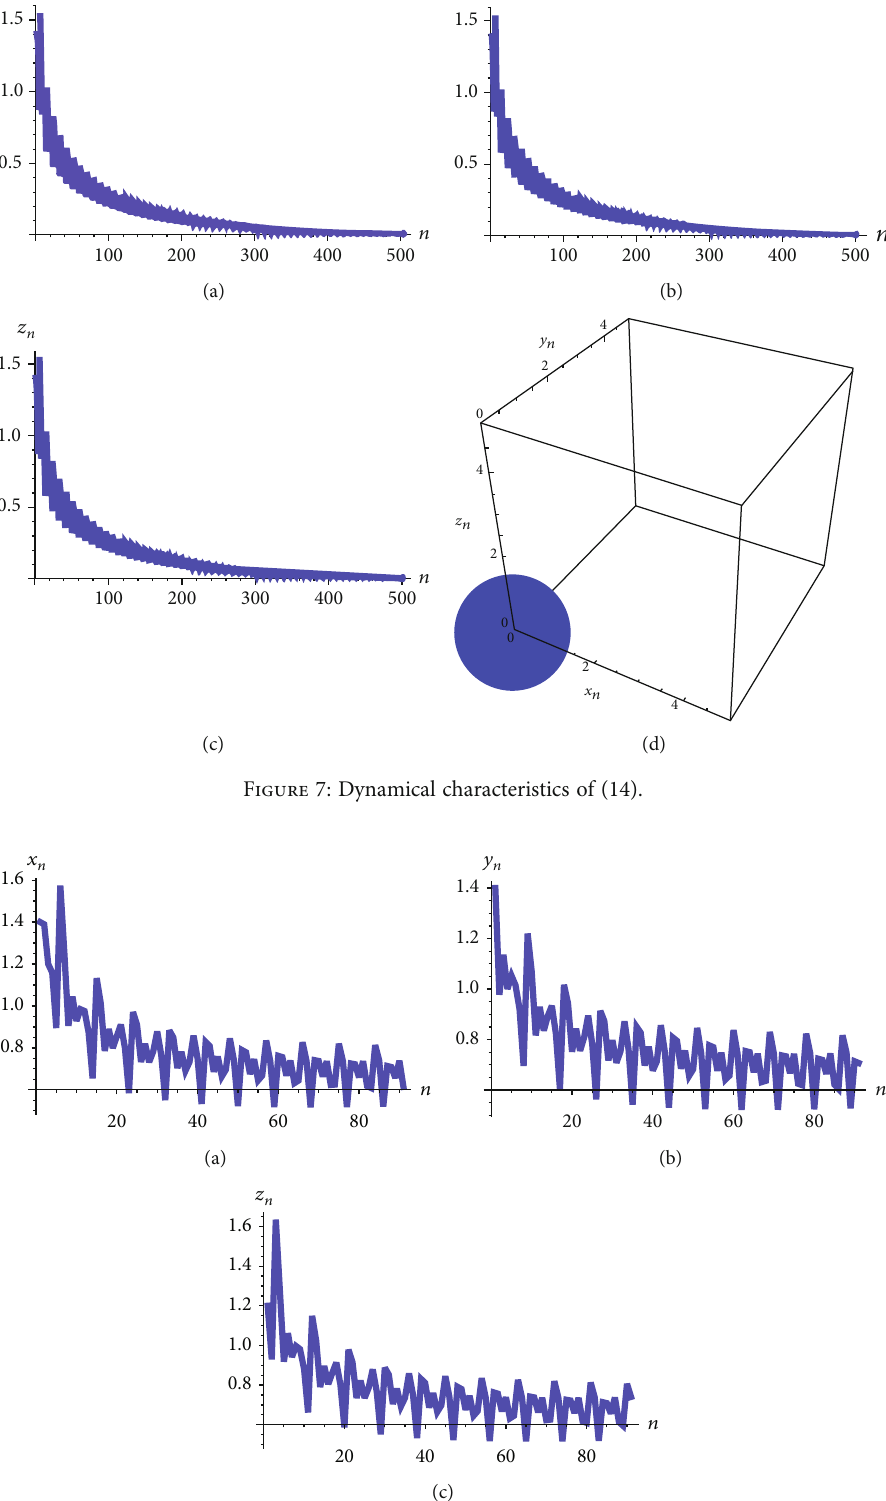
Figure 8: Dynamical characteristics of